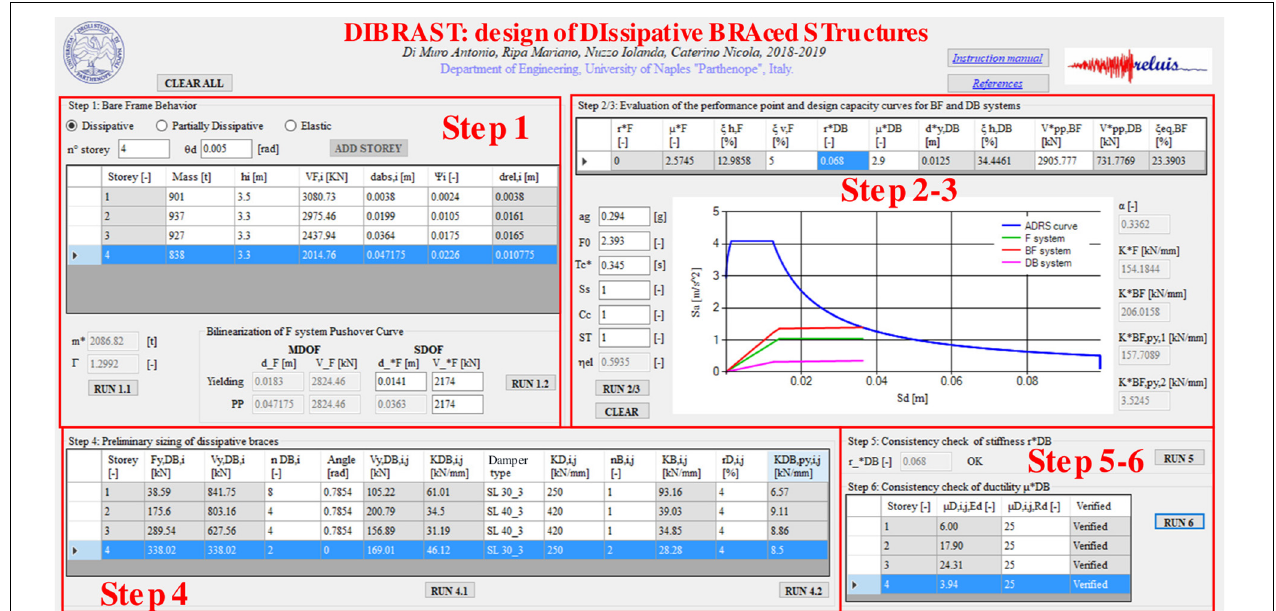
FIGURE 2 | Screenshot of DIBRAST : a tool for preliminary sizing of dissipative systems.